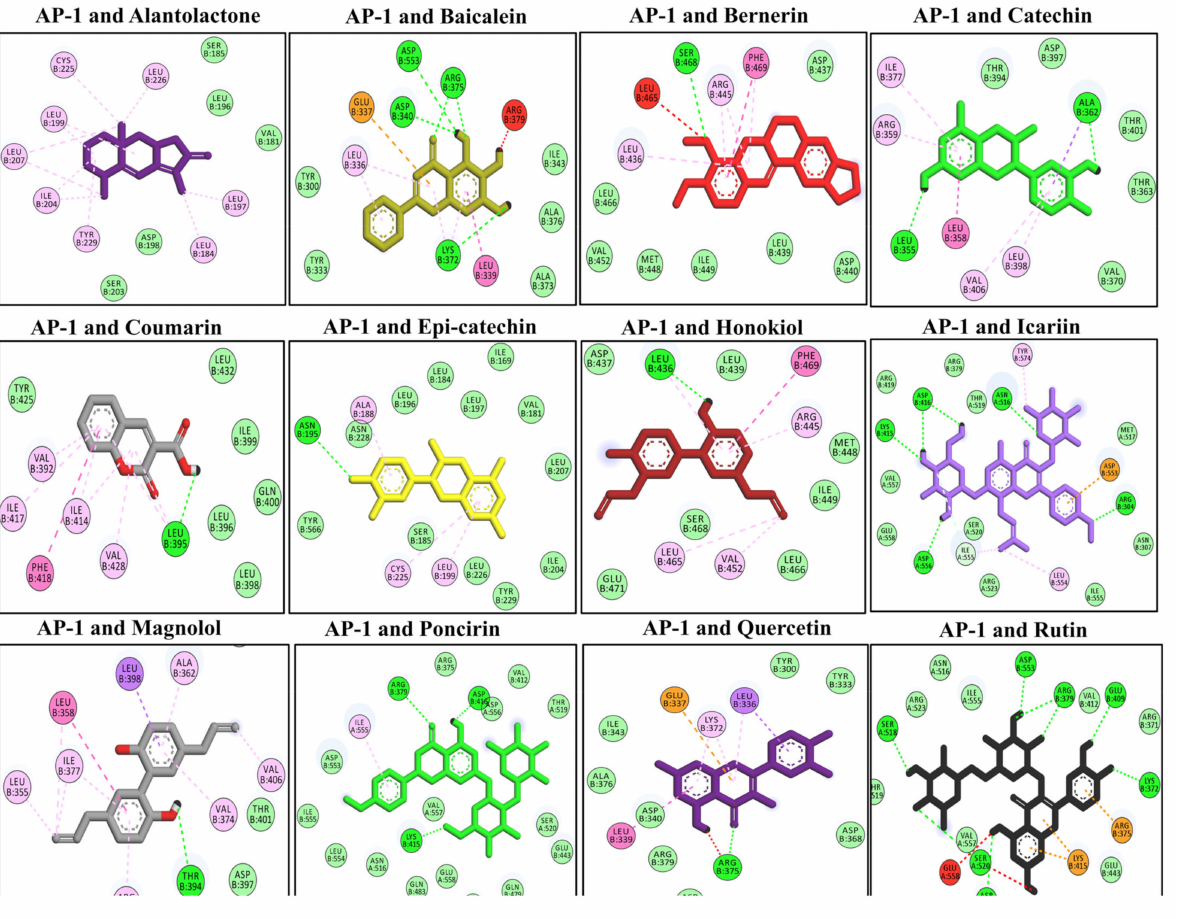
Figure 7. The molecular docking analysis of the selected compounds with the AP-1 protein using AutoDock Vina software. The molecular docking showed binding of the studied ligand with AP-1 via multiple hydrophilic and hydrophobic bonds. The ligand and protein interactions were visualized in Discovery Studio Visualizer_16 and ligands whose negative binding energy was high were